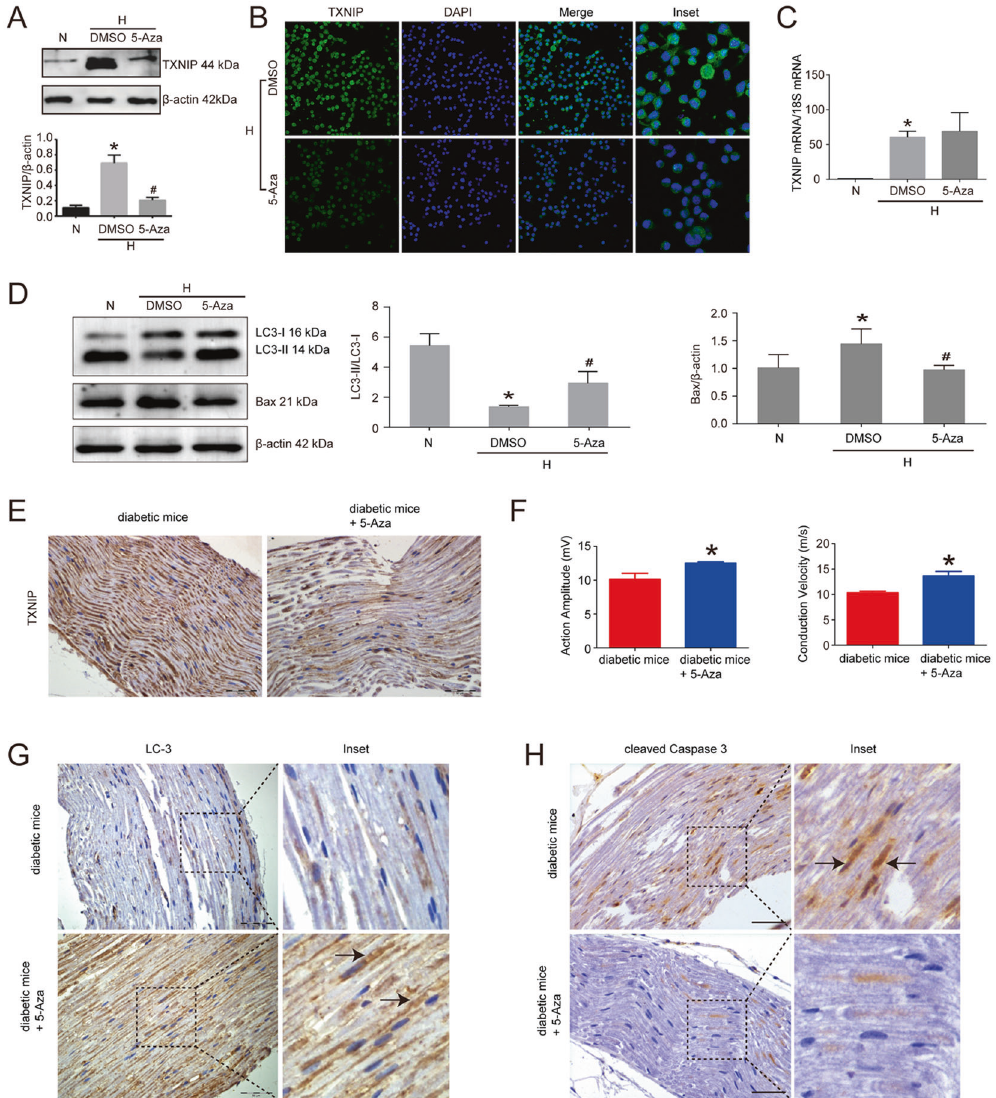
Fig. 4 5-Aza inhibited TXNIP expression in high glucose-treated RSC96 cells and the sciatic nerves of diabetic mice. A Western blot and statistical analysis of the effect of 5-Aza on TXNIP expression in high glucose-cultured RSC96 cells. * P < 0.05 versus N group. # means P < 0.05 versus DMSO group. B Immuno fl uorescence of TXNIP in high glucose-cultured RSC96 cells treated with DMSO and 5-Aza. Bar: 50 μ m. C Real- time PCR of TXNIP mRNA in high glucose-cultured RSC96 cells treated with DMSO and 5-Aza. * P < 0.05 versus N group. D Western blot and statistical analysis of the effect of 5-Aza on LC3 and Bax in RSC96 cells. * P < 0.05 versus N group. # P < 0.05 versus DMSO group. E Immunohistochemistry of TXNIP in the sciatic nerves of diabetic mice administrated with 5-Aza or not. Bar: 50 μ m. F Electrophysiological detection of action amplitude and conduction velocity of the sciatic nerves of diabetic mice administrated with 5-Aza or not. * P < 0.05 versus diabetic mice. G Immunohistochemistry of LC3 in the sciatic nerves of diabetic mice administrated with 5-Aza or not. The inset was shown with dashed square. Black arrows showed the positive staining of LC3. Bar: 50 μ m. H Immunohistochemistry of cleaved Caspase 3 in the sciatic nerves of diabetic mice administrated with 5-Aza or not. The inset was shown with dashed square. Black arrows showed the positive staining of cleaved Caspase 3. Bar: 50 μ